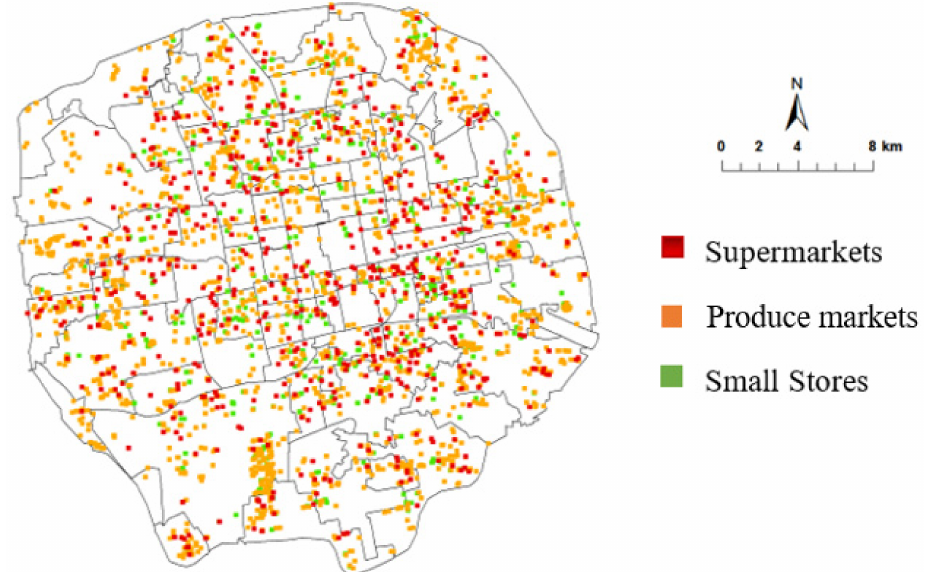
Figure 2. Distribution of the three types of food retail